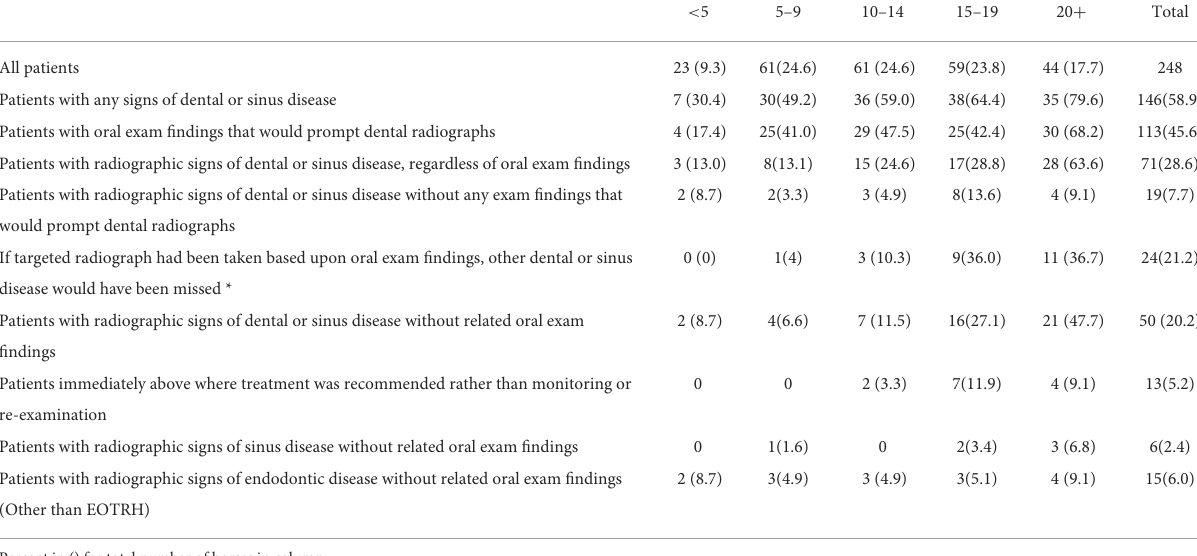
TABLE 3 General dental and sinus